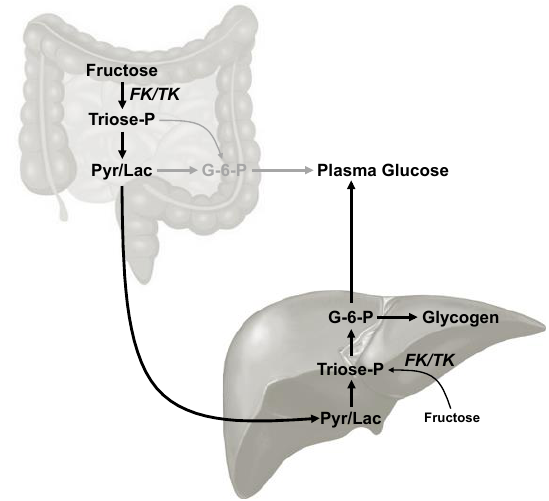
Figure 6. Metabolic model describing intestinal and hepatic routes of fructose catabolism from a protein meal supplemented with 50 g of a 55/45 fructose/glucose mixture corresponding to HFCS-55. Following entry into the glycolytic triose-P intermediates via fructokinase and triokinase (FK/TK), conversion of the pyruvate/lactate intermediate (Pyr/Lac) to glucose can occur by hepatic gluconeogenesis (in black) or by intestinal gluconeogenesis (in gray). Overall, conversion of fructose to glucose-6-P via triose-P is minor in comparison to its conversion via